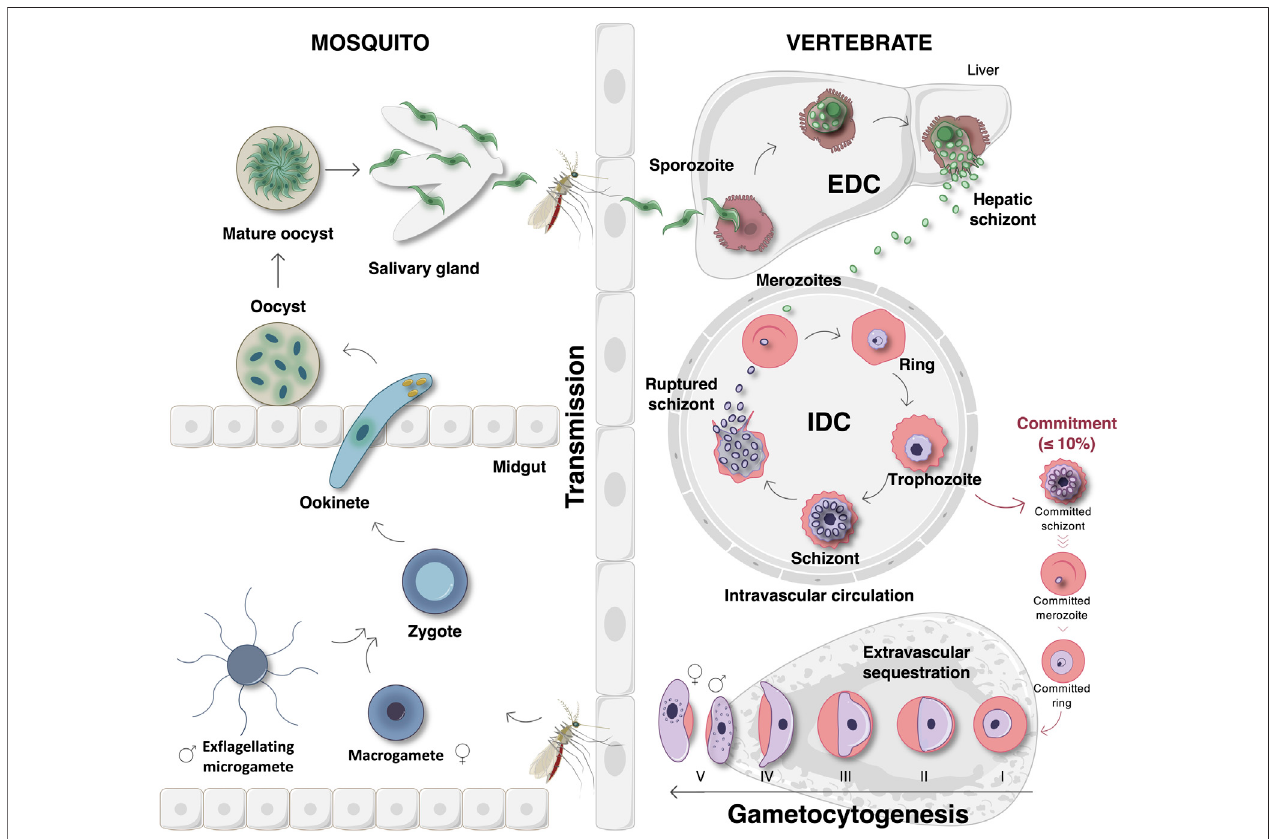
FIGURE 1 | The life cycle of P. falciparum parasites. The life cycle begins when an Anopheles mosquito vector injects sporozoites into the circulatory system of a human host. The sporozoites then travel to and invade liver cells to initiate the exoerythrocytic developmental cycle (EDC) that results in the formation hepatic schizonts. Once mature, these hepatic schizonts release merozoites into the peripheral circulation. Merozoites invade erythrocytes and initiate the 48-hour intraerythrocytic developmental cycle (IDC) that involves asexual proliferation through ring, trophozoite, and schizont stages. Schizonts then rupture and release new daughter merozoites that repeat this cycle once again. Within each IDC, a small proportion ( ≤ 10%) of the parasites will deviate from this fate and instead commit to gametocytogenesis.Sexuallycommittedmerozoitesinvadeerythrocytes,formingstageIgametocytesthatsequesterinthebonemarrowwheresubsequentmaturation into gametocyte stages II – IV occurs. Gametocytogenesis yields mature stage V gametocytes that re-enter into the host ’ s circulatory system where they are ideally situated for transmission to the mosquito during feeding. Once taken up during a blood meal, gametogenesis ensues in the mosquito midgut in which female macrogametes are formed and male gametocytes undergo ex fl agellation to form microgametes. Thereafter, the microgametes fertilize macrogametes, forming diploid zygotes. Zygote development involves maturation into an ookinete and then an oocyst that contains new, maturing sporozoites. Finally, the mature oocysts rupture, releasing sporozoites that travel to the mosquito ’ s salivary glands where they will be transmitted to a new host during feeding. Image was created with BioRender.com.